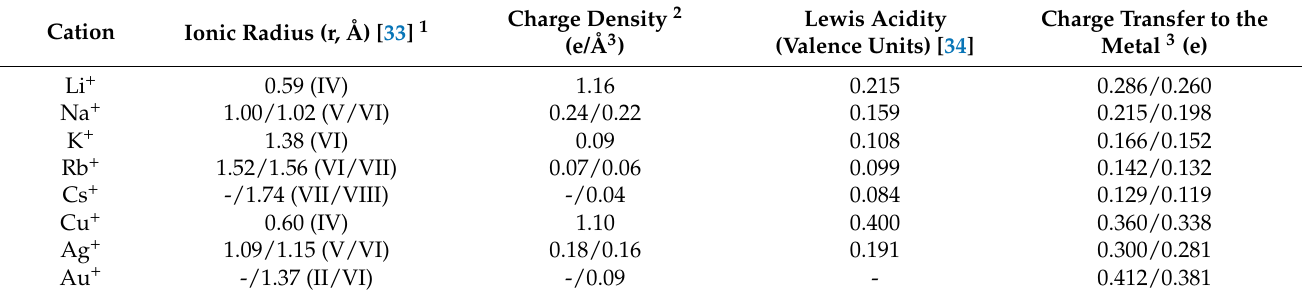
Table 1. Structural and thermodynamic characteristics of alkali and coinage metal